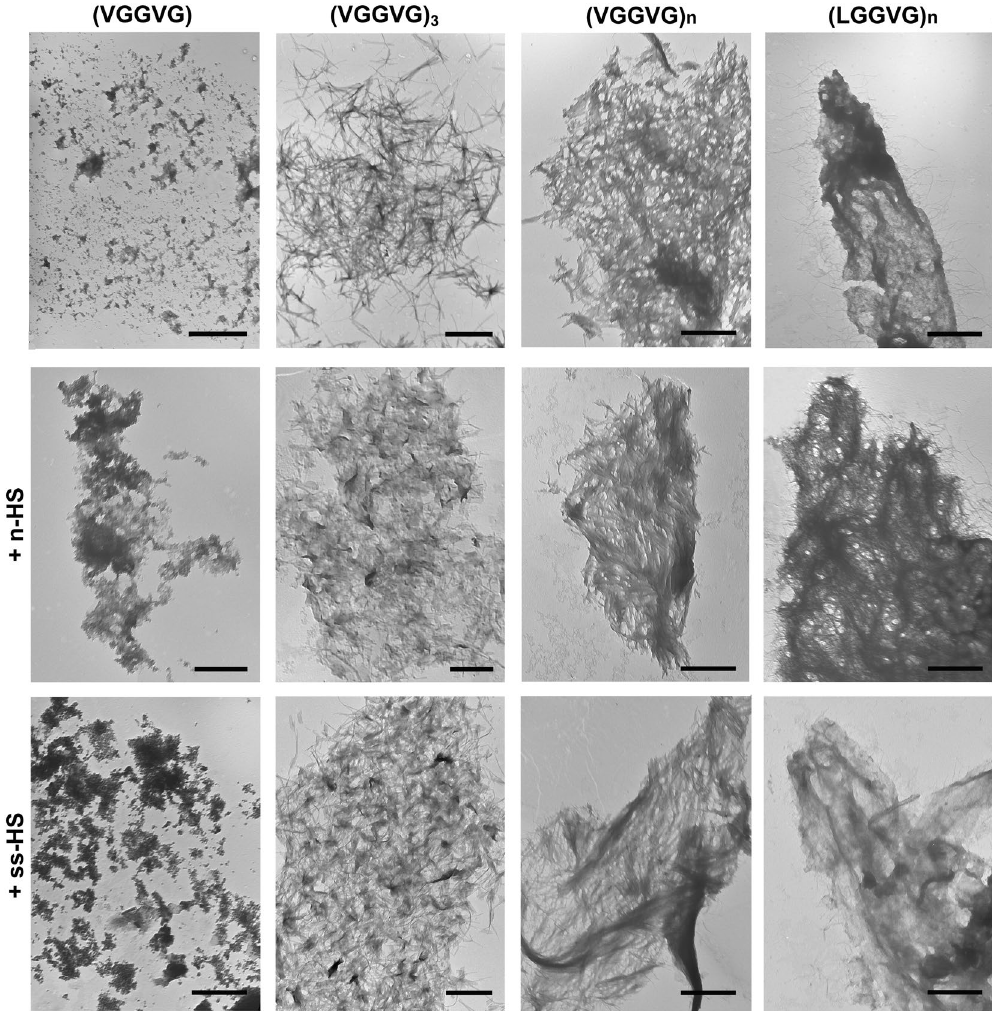
Figure 2. Transmission electron microscopy. Images show (VGGVG), (VGGVG) 3 , (VGGVG) n and (LGGVG) n incubated in water for 24 h at 37 °C in the absence or in the presence of natural (n-HS) or of semisynthetic (ss- HS) heparan sulfates. Samples are negatively stained on formvar coated copper grids. Bars: 1 μ